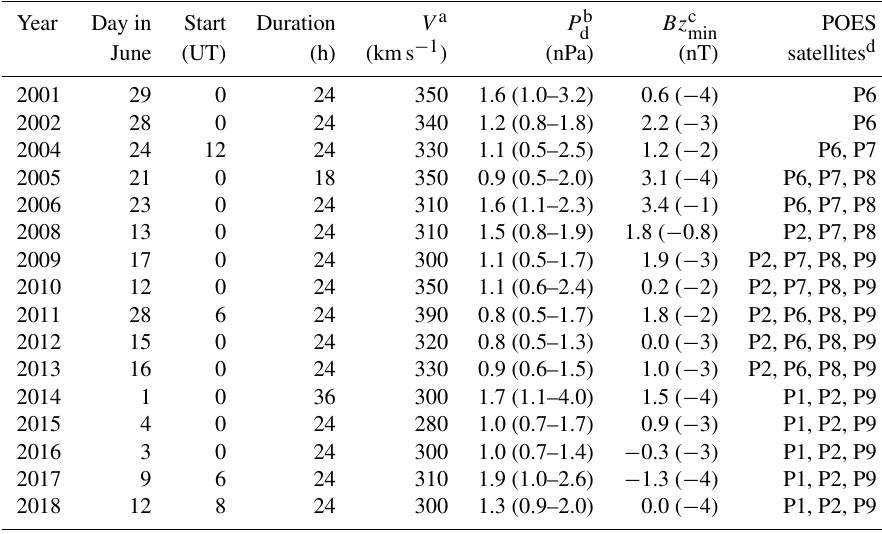
Table 2. List of quiet days in June selected for POES observations of the outer radiation